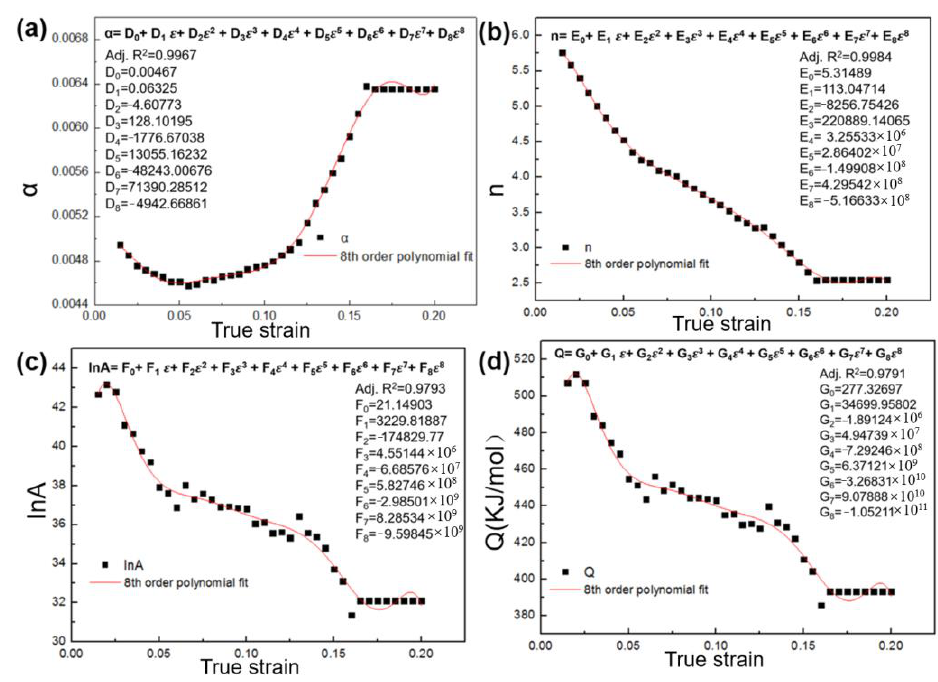
Figure 13. The fitted curves of the materials constant: ( a ) α ; ( b ) lnA; ( c ) n; ( d ) Q. According to the calculation results of Arrhenius model, there are deviations in var- ying degree between the experimental results and the prediction results. Figure 14 only shows the deviations at 𝜀̇ = 0.001 and 𝜀̇ = 0.01. In Figure 14, the deviations in the y direc- tion are large and decrease with the increasing temperature, but the variation trend of the prediction points is consistent with the experiment curves. The deviation in the y direction can be defined by the following equation: